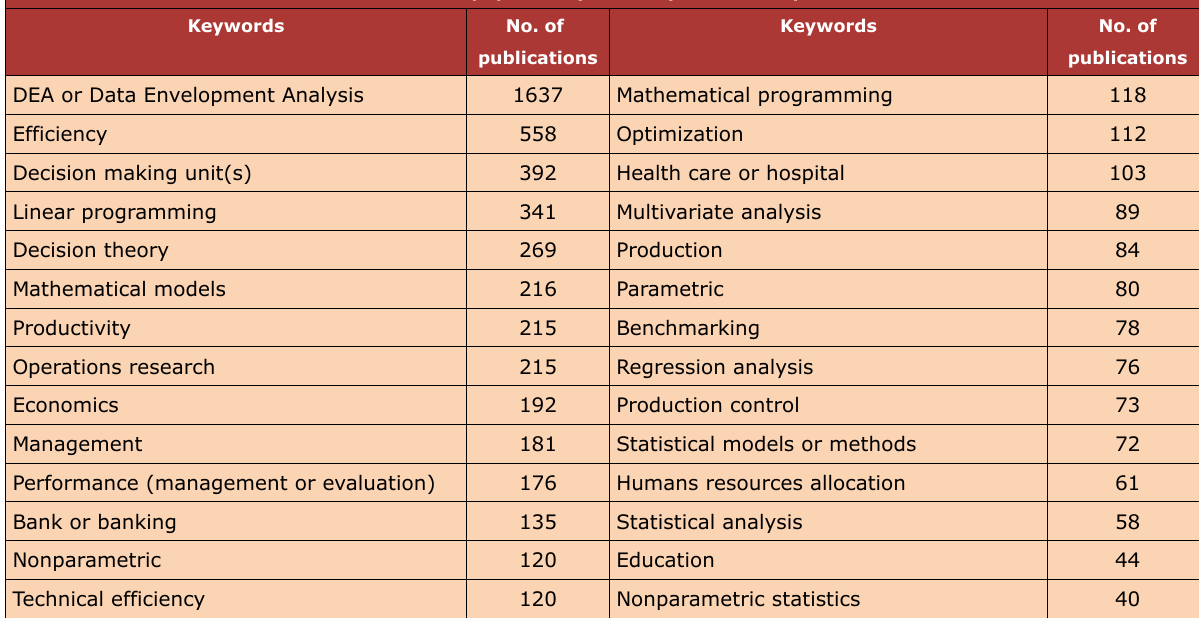
Table 2. DEA popular key words (Excerpted from Emrouznejad, et.al.,